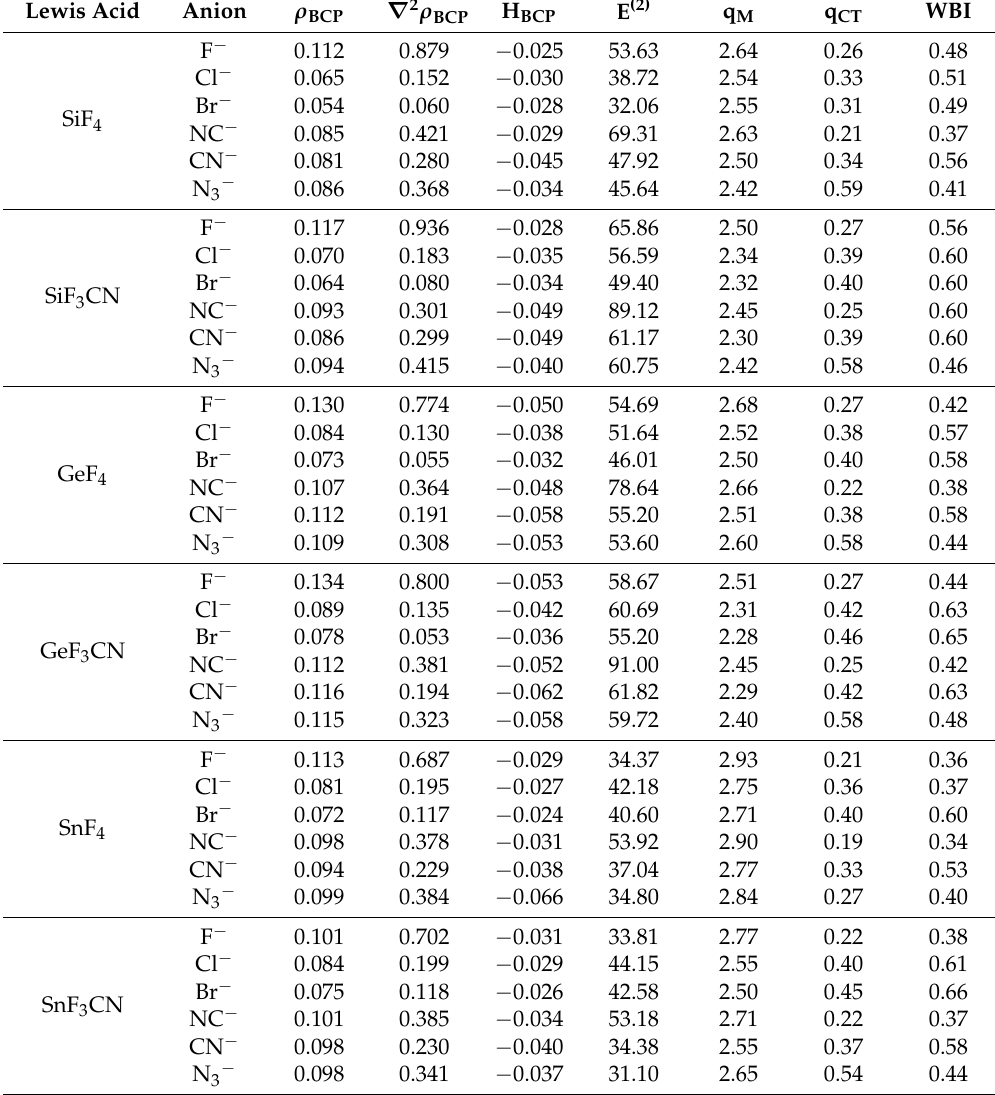
Table 2. Electron density ( ρ BCP , au), its Laplacian ( ∇ 2 ρ BCP , au) and total electron energy density (H BCP , au) at the M ··· A − BCPs, and NBO stabilization energy (E (2) , kcal/mol), atomic charge on the M atom (q M , e), net charge-transfer (q CT , e) and Wiberg bond index (WBI) values of the anionic tetrel-bonded